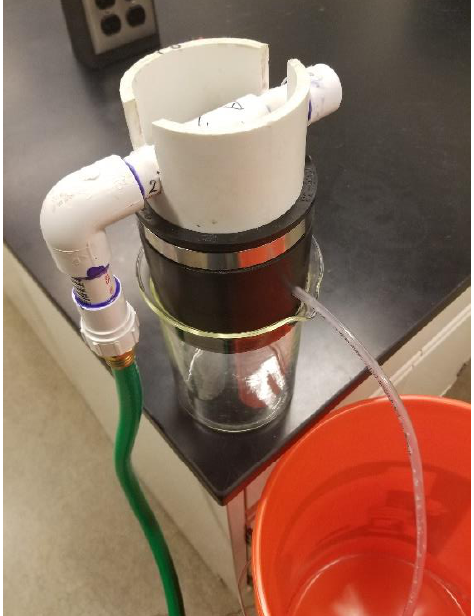
Figure 8. The experimental setup for determining flowrate through the flow-reduction cap.